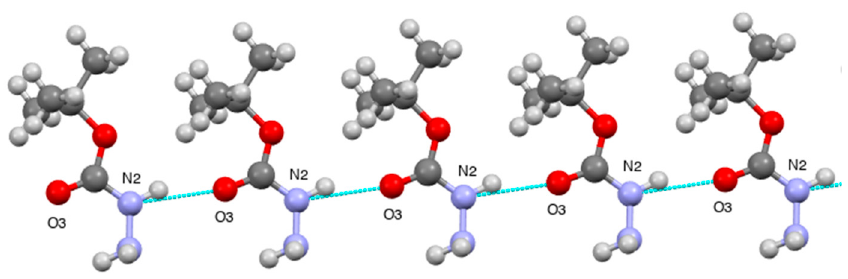
Figure 4. Hydrogen-bonding pattern within one chain of molecules.